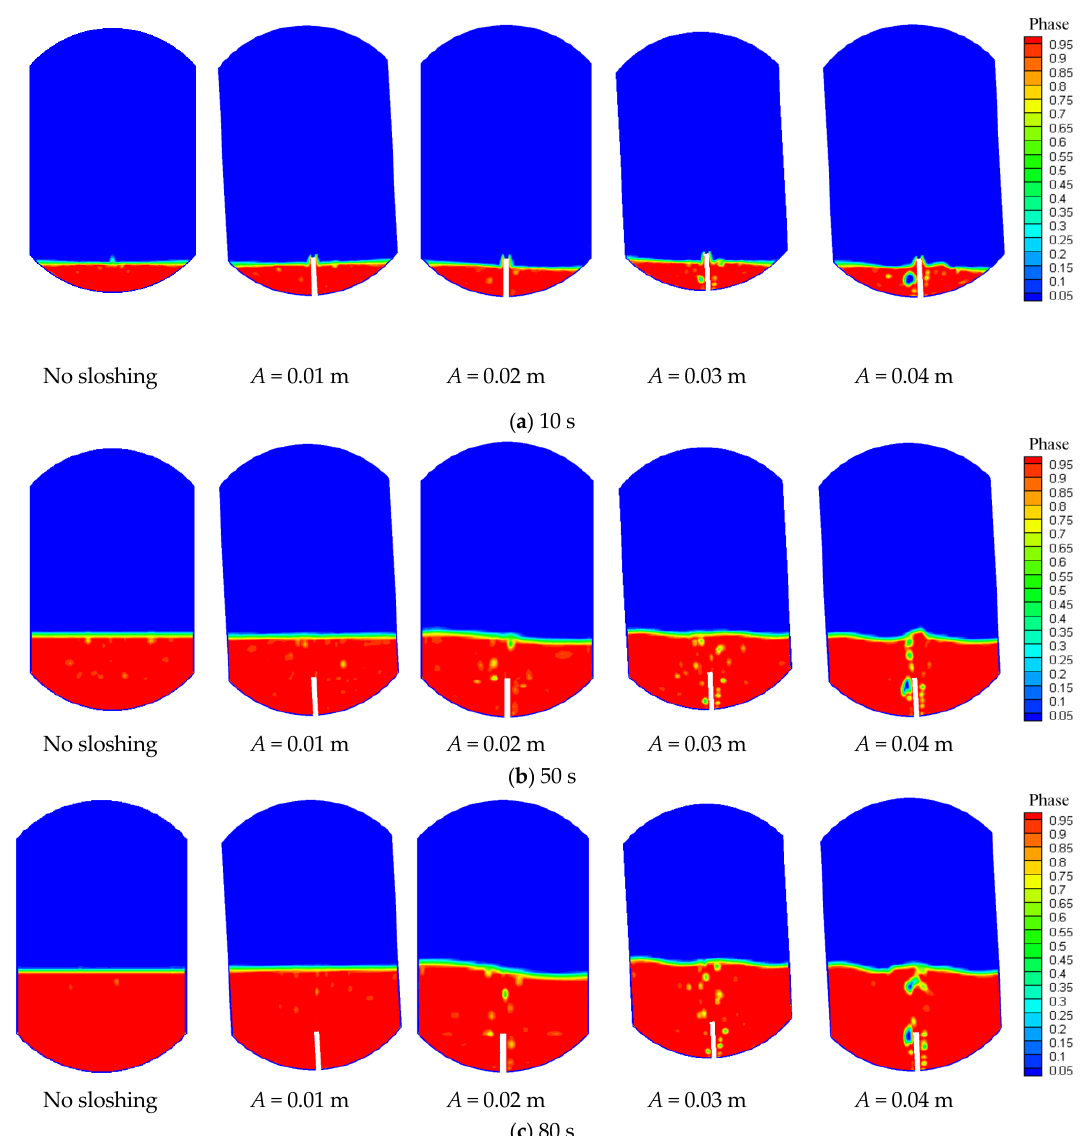
Figure 13. Graphic contours of phase distribution under different sloshing amplitudes ( f = 3 Hz) at ( a ) 10 s, ( b ) 50 s, and ( c ) 80 s.